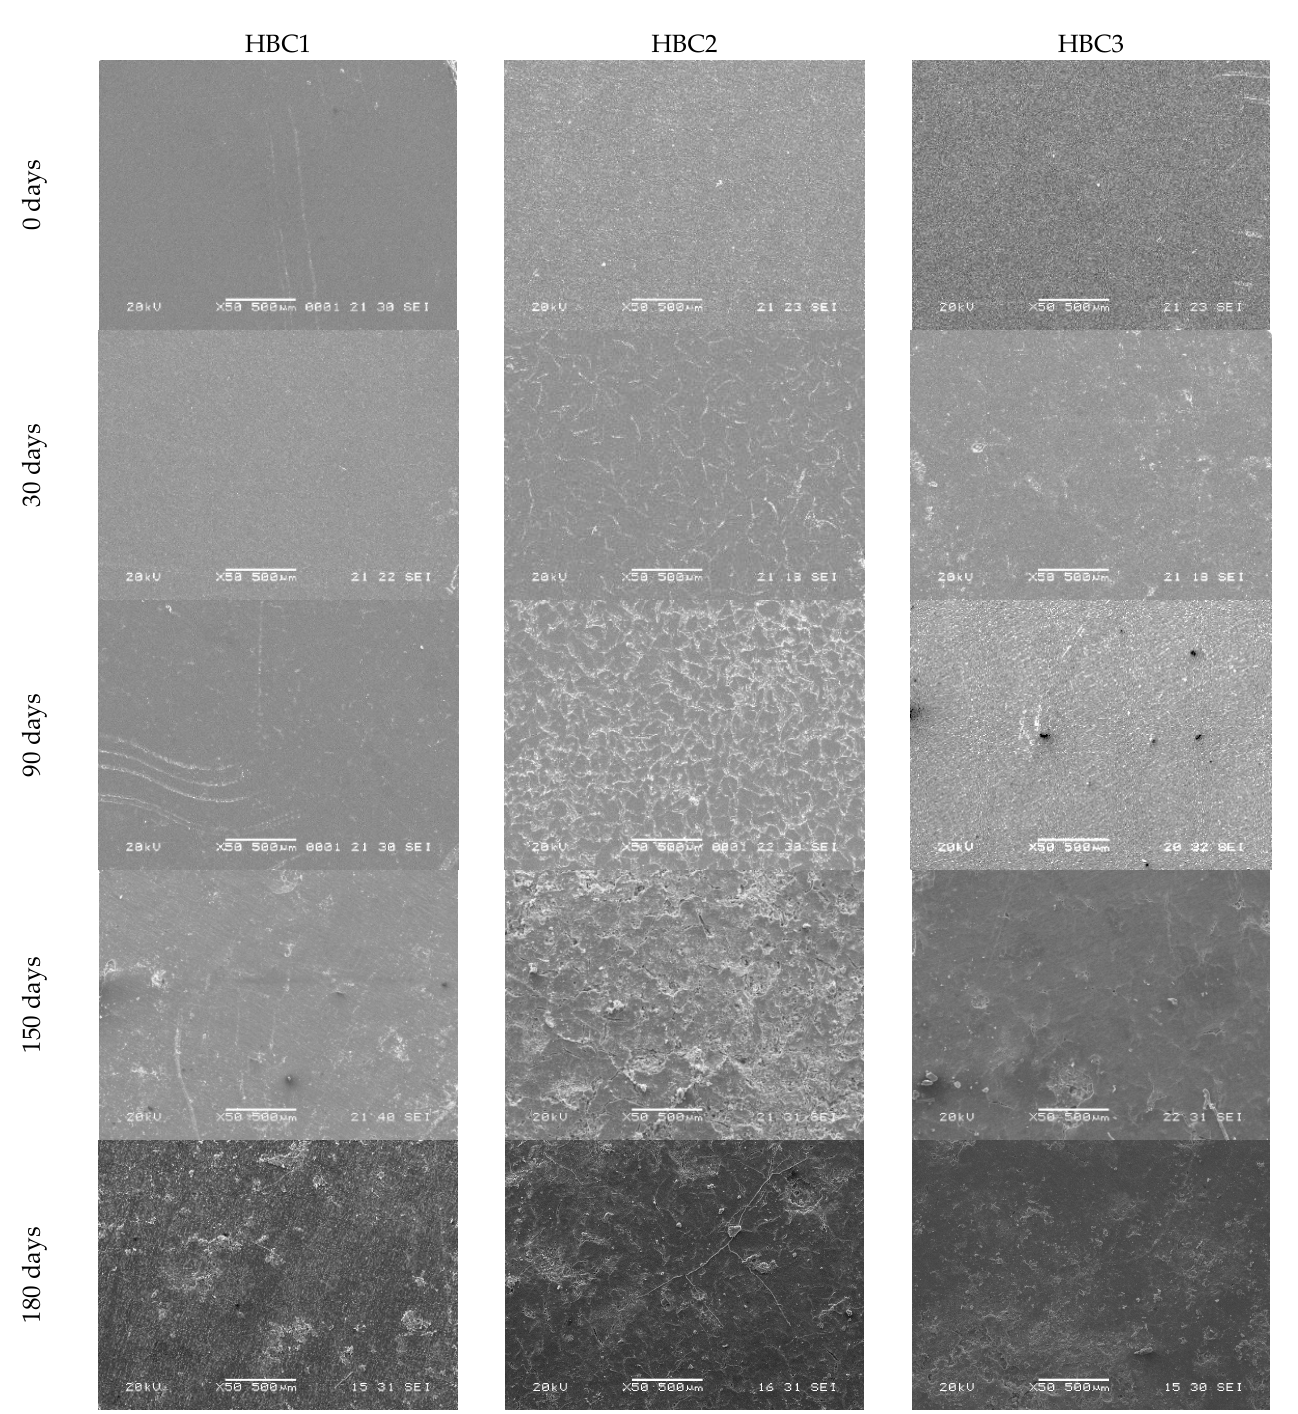
Figure 1. HBC1, HBC2 and HBC3 SEM micrographs at different composting days (0, 30, 90, 150, and 180 days).